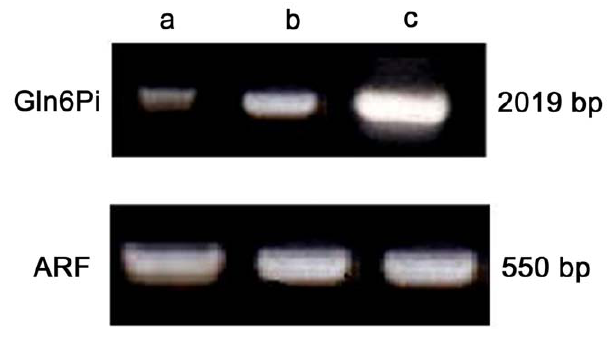
Figure 3. Gln6Pi enzyme mRNA expression levels assessed by RT-PCR in E.histolytica CLS resistant to detergents. Total RNA was purified from untreated trophozoites (lane a), cysts isolated from human feces (lane b) and the CLS (lane c) and RT-PCR amplified by using specific oligonucleotides for E. histolytica Gln6Pi gene. Clear over- expression of Gln6Pi is observed in CLS (25 folds) respect to the basal expression in untreated trophozoites. Parallel RT-PCR amplification of the ADP-ribosylating factor (ARF) for each sample was used as internal loading control.